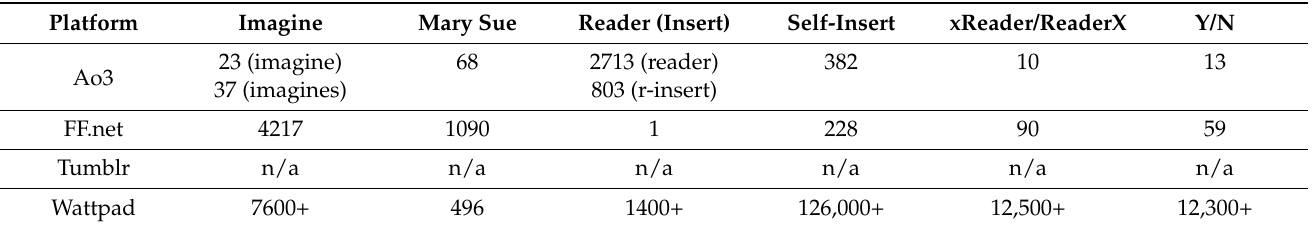
Table 1. All results documented here stem from searches for Harry Potter self-insert fanfiction conducted in February and March 2022 using the term(s)